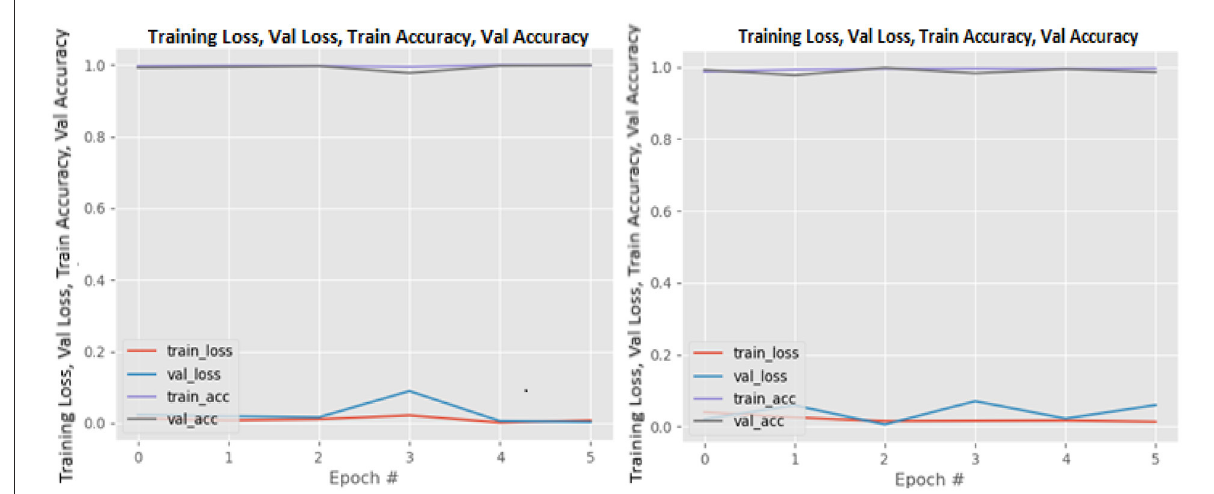
FIGURE15 ResNet50 without data augmentation (left image) and with data augmentation (right image).